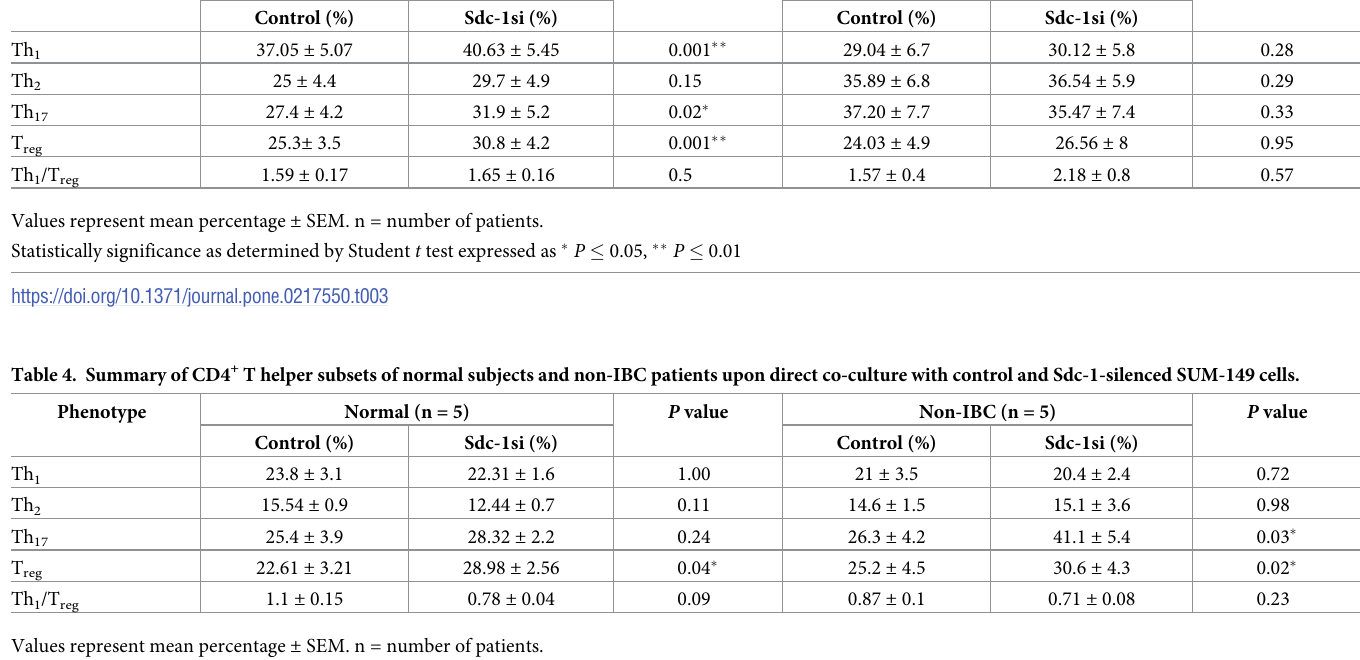
Table 3. Summary of CD4 + T helper subsets of non-IBC and IBC patients upon stimulation with the secretome of control and Sdc-1-silenced SUM-149 cell. Phenotype